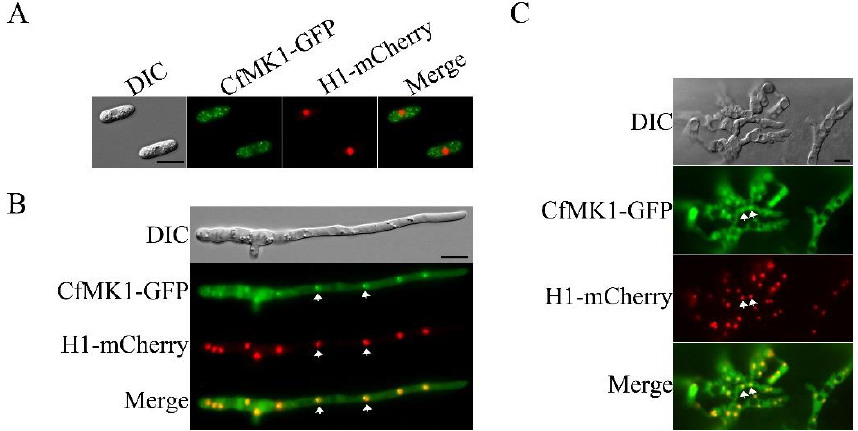
Figure 7. Expression and localization of CfMK1-GFP. Conidia ( A ), germ tube ( B ), and invasive hyphae ( C ) of the Δ Cfmk1 / CfMK1 -GFP transformant expressing the CfMK1-GFP and H1-mCherry fusion constructs. Fluorescent nuclei are marked with arrows. Bars = 10 μm.